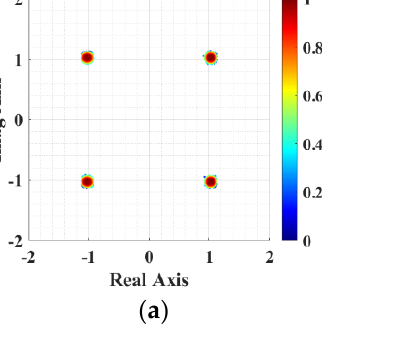
( c ) Figure 2. The PDF of n-level polybinary transformation for QPSK signal: ( a ) 1-level polybinary transformation of original signal; ( b ) duobinary transformation; ( c ) tribinary transformation.